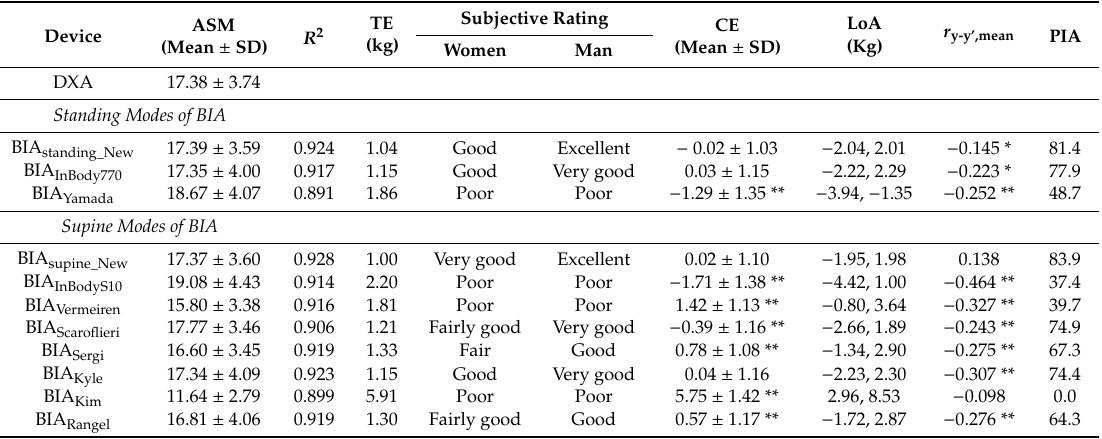
Table 4. External cross-validation of BIA equations and devices for ASM measured by dual-energy X-ray absorptiometry